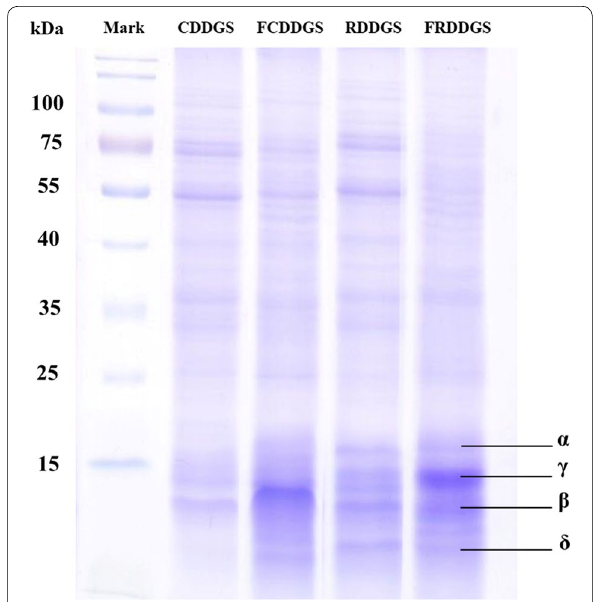
Fig. 4 Sodium dodecyl sulfate polyacrylamide gel electrophoresis (SDS-Page) of CDDGS, FCDDGS, RDDGS and